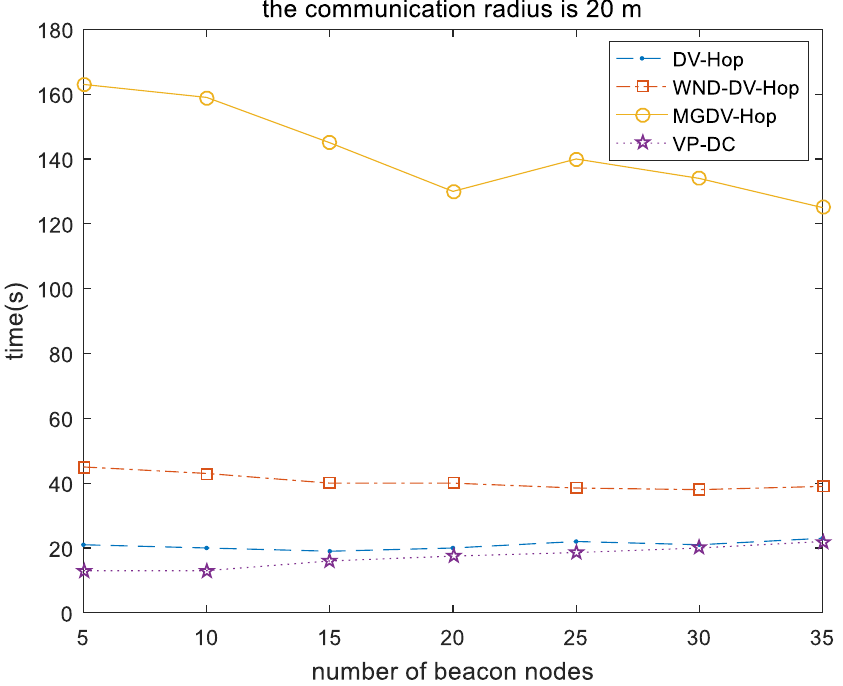
Figure 7. Relationship between the number of beacon nodes and the average localization error.